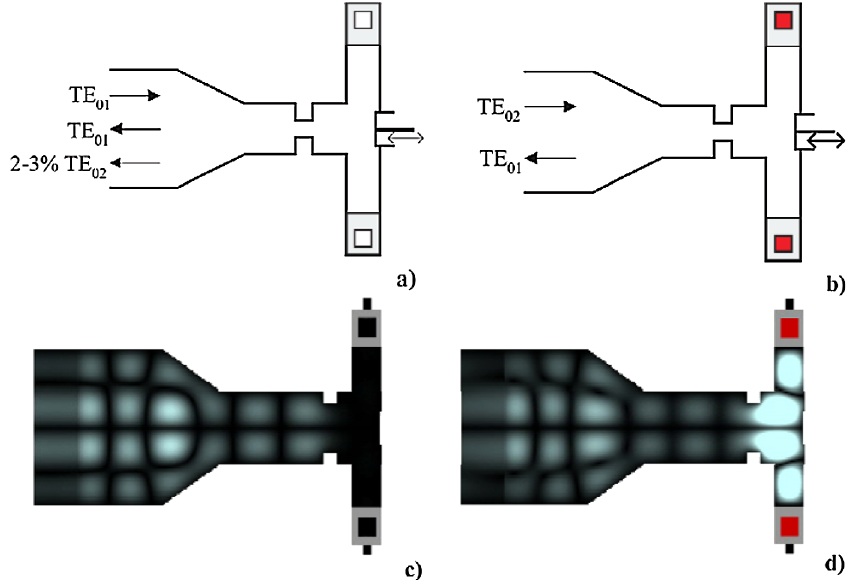
FIG. 10. (Color) Schematic diagrams [(a) and (b)] and instantaneous electric field distribution [(c) and (d)] in the plasma switch based ! TE mode conversion, illustrating switch operation in the (a) and (c) energy storage and (b) and (d) microwave pulse on TE 02 01 extraction